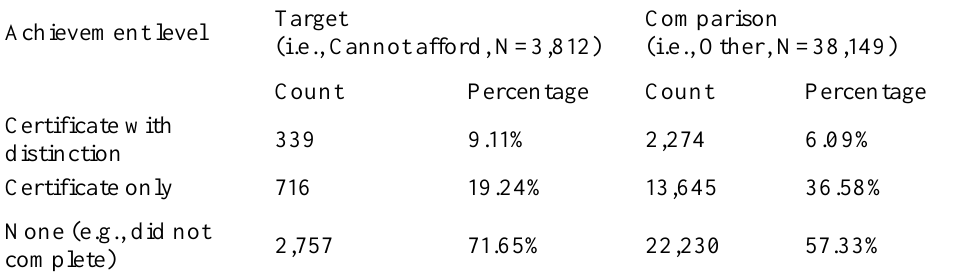
Level of Completion Based on Affordability Achievement